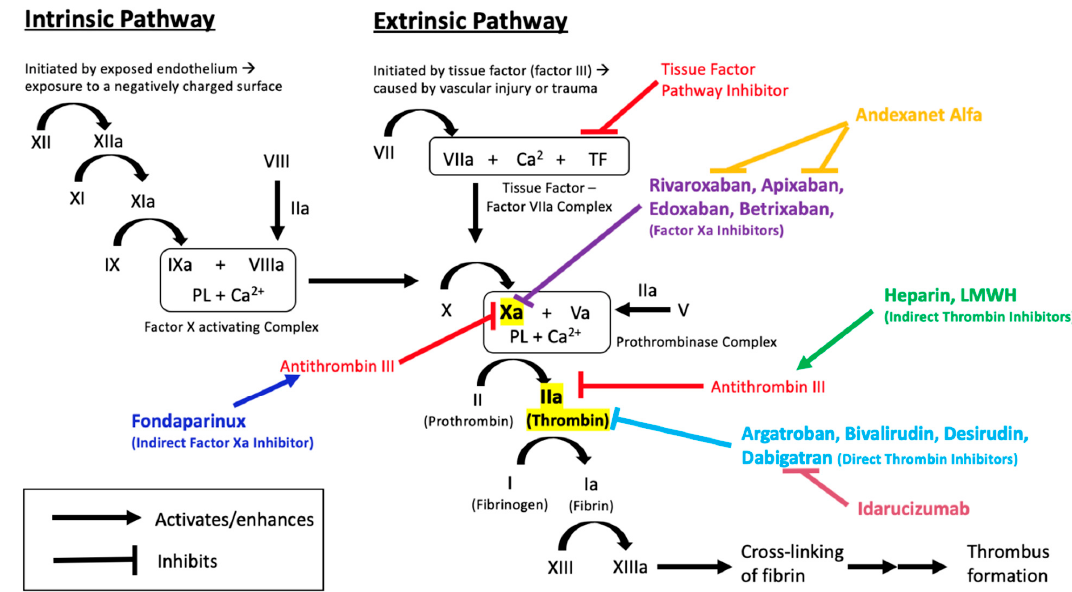
Figure1. Overviewofthecoagulationcascade, indicatingthesitesofactionofanticoagulantmedications Figure 1. Overview of the coagulation cascade, indicating the sites of action of anticoagulant and their reversal medications and their reversal agents.